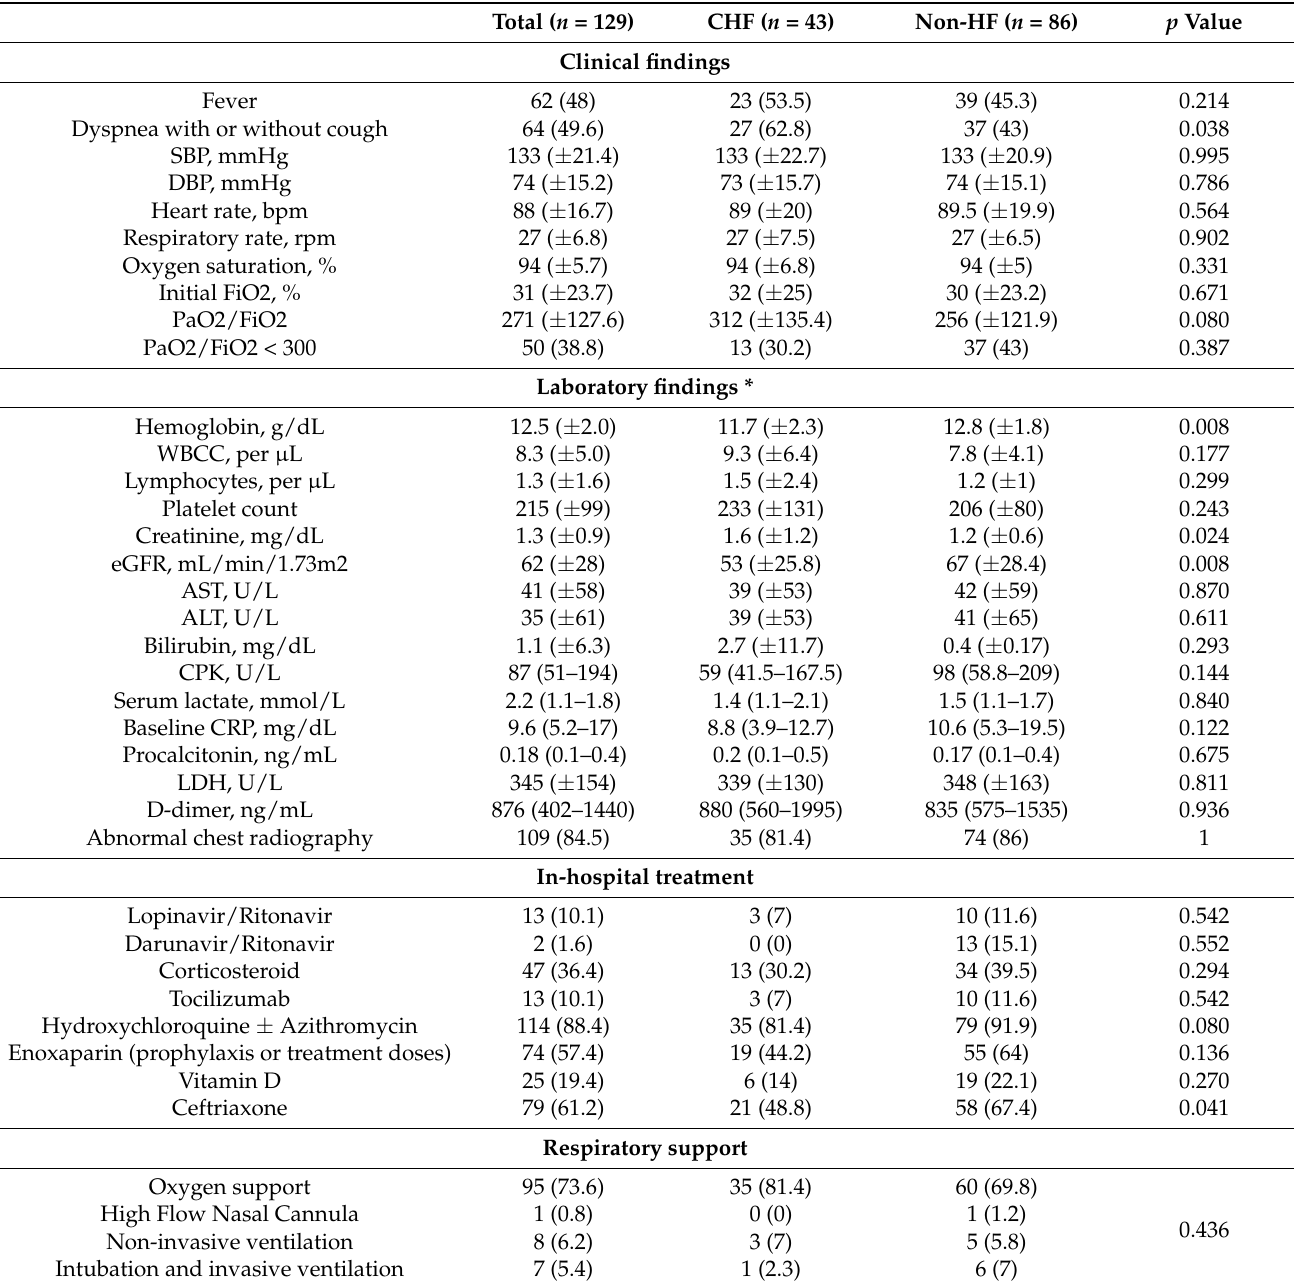
Table 2. Clinical presentation, laboratory findings on admission and in-hospital treatment of patients stratified by heart